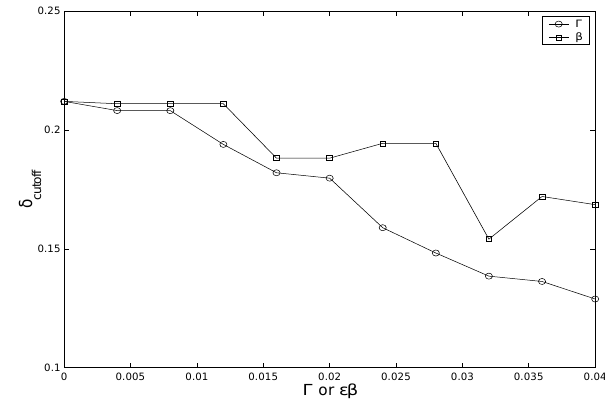
Fig. 20. The damped HONLS equation ( (cid:15) = 0 . 05): δ damped Fig. 20: The damped HONLS equation ( ǫ = 0 . 05 ): δ damped function of 0 (circles) and (cid:15)β as a function of Γ (circles) and ǫβ (boxes)